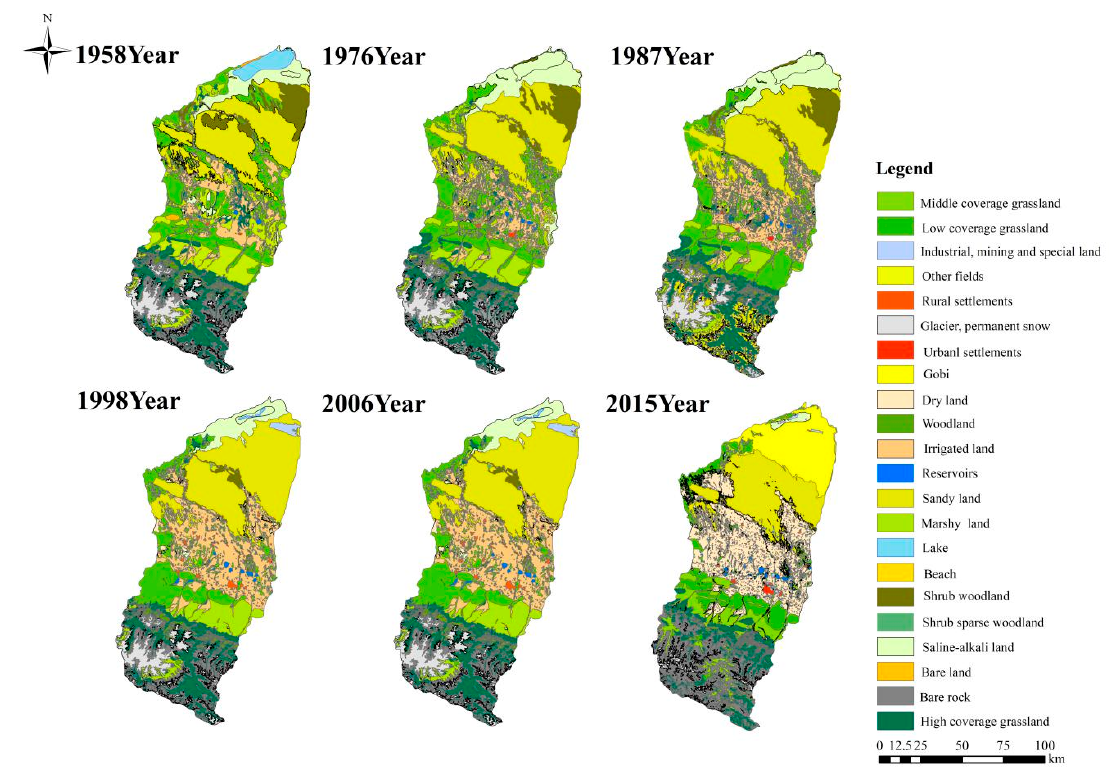
Figure 2. Land use types in the Manas River Basin, 1976–2015.